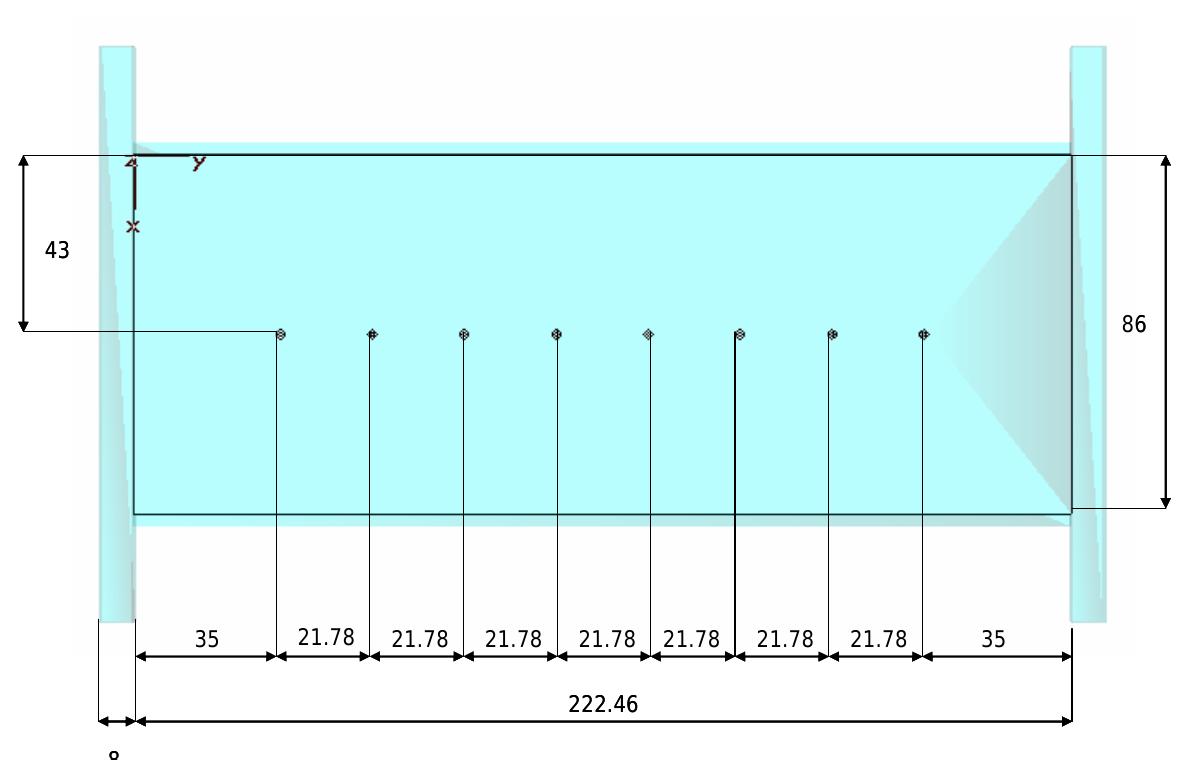
Figure 6. Ten-port length and distances (in mm) between